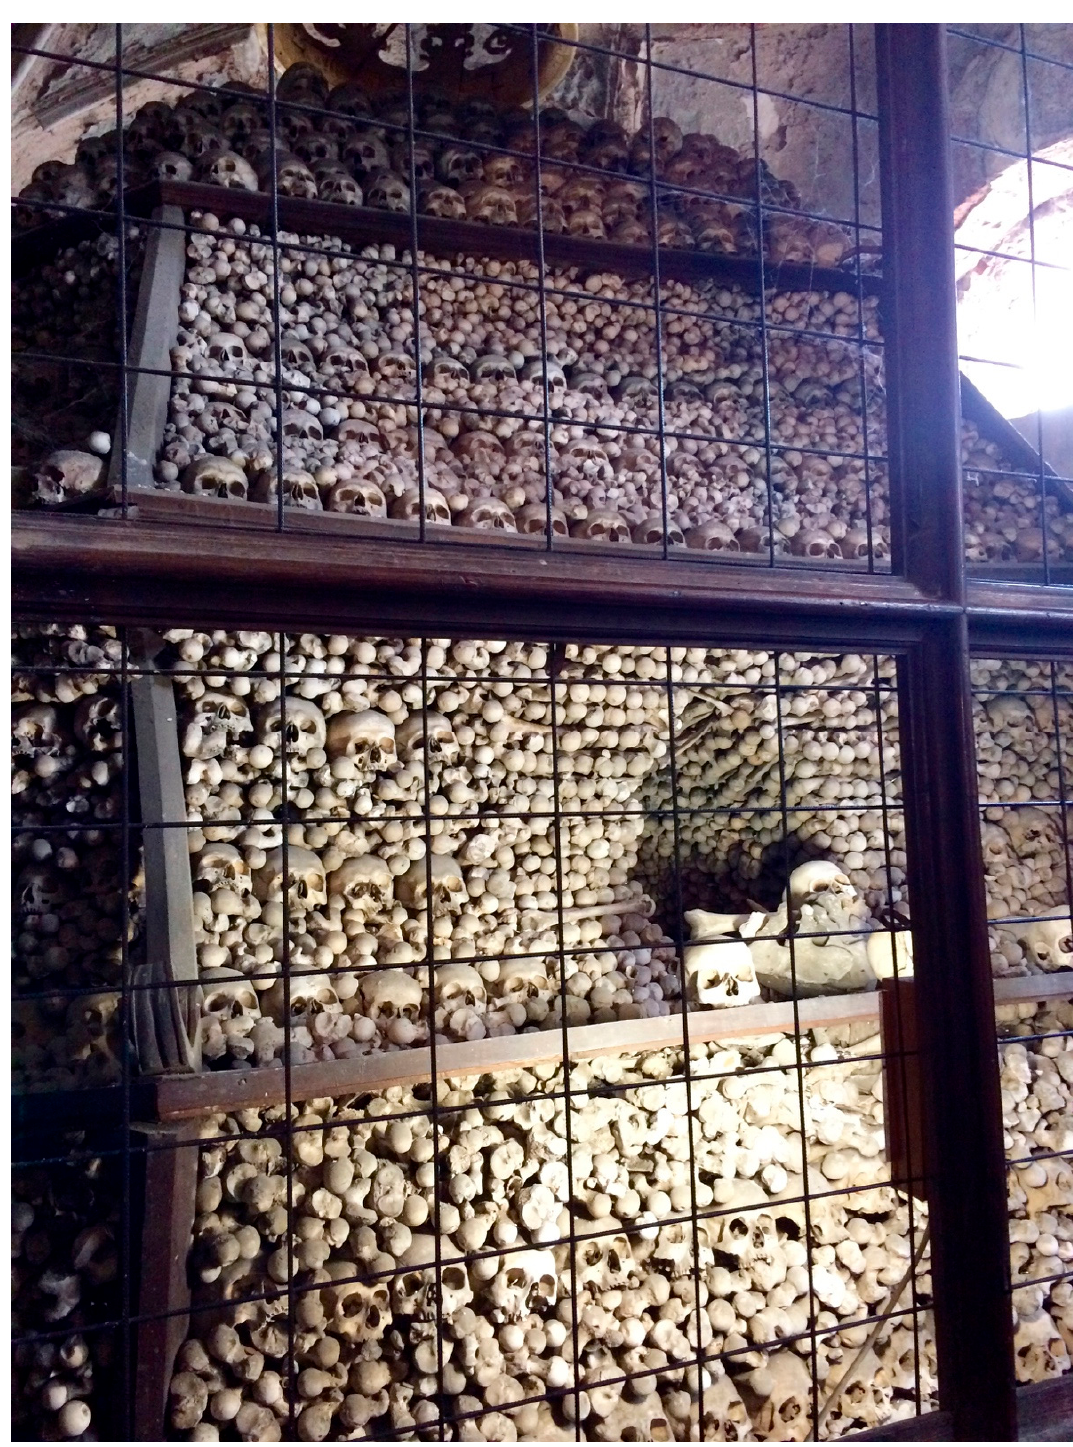
Figure 3. Sedlec Ossuary, bone memorial display, interior, May 2016. Kelsey Perreault.